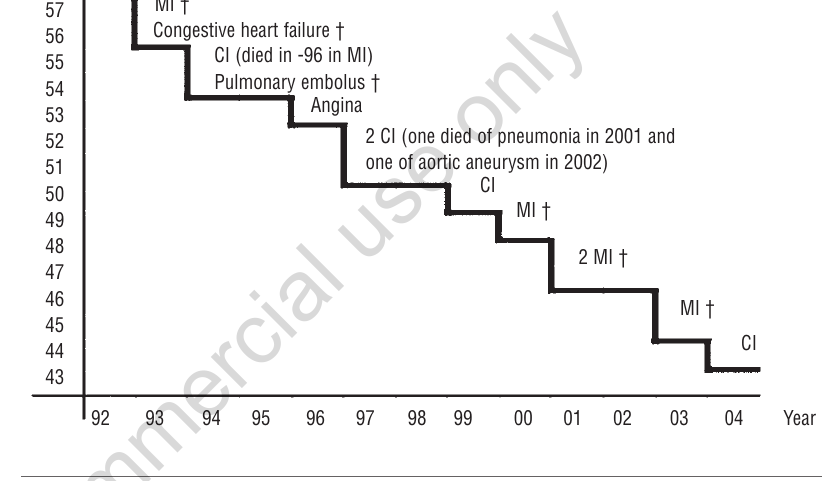
Figure 2. Kaplan-Meyer graph of cerebro- and cardiovascular events during follow-up. MI: myocardial infarction; CI: cerebral infarction; TIA: transitory ischemic attack; †: